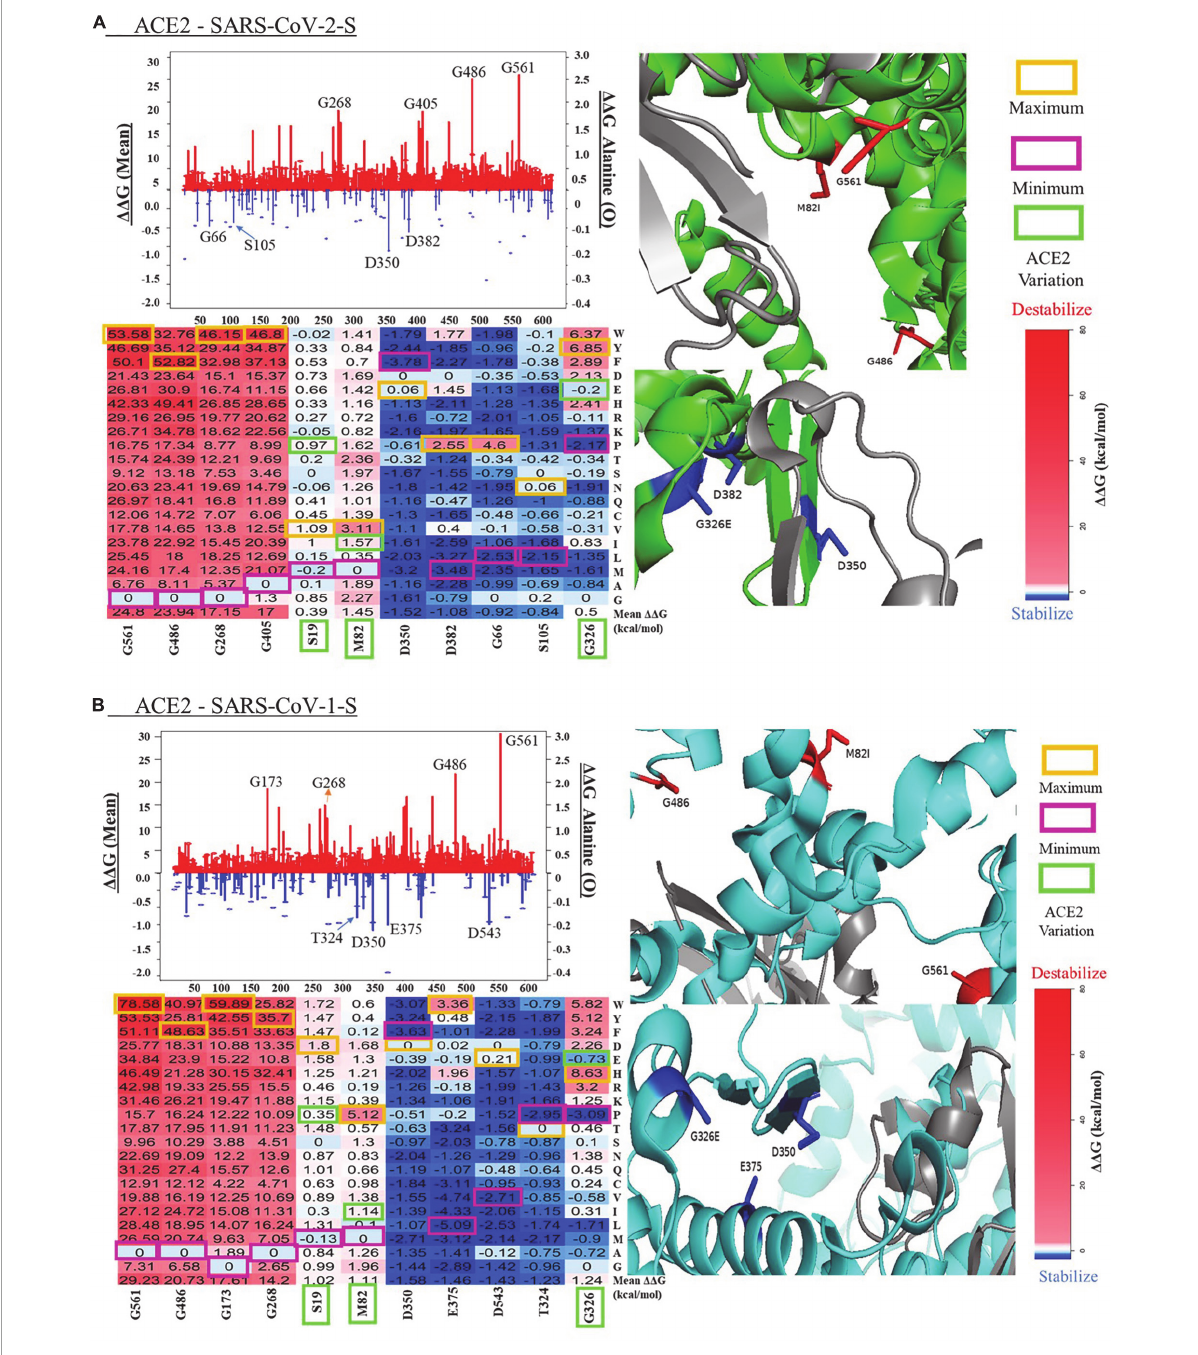
FIGURE2 Visualization of key residues affecting protein in panel (A) ACE2 - SARS-CoV-2 and (B) ACE2 - SARS-CoV-1-S complexes. The lines (mean (cid:49)(cid:49) G, kcal/mol) and bubbles ( (cid:49)(cid:49) G of alanine mutations, kcal/mol) shown the destabilization (red) and stabilization (blue) effects (The scales of y-axis for two effects are different for clear visualization). ACE2 is shown in green or cyan, and the SARS-CoV-2/1 (S) protein is shown in gray. In the heatmaps of key residues, maximum values (orange), minimum (magenta), and the genetic variants (green) are labeled for the